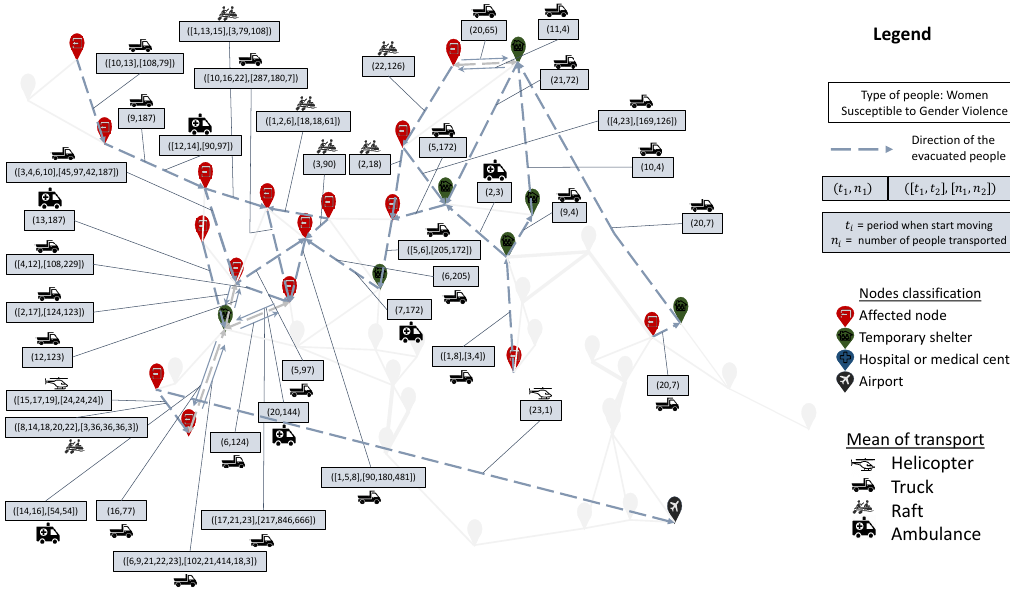
Figure 5. Evacuation of women susceptible to